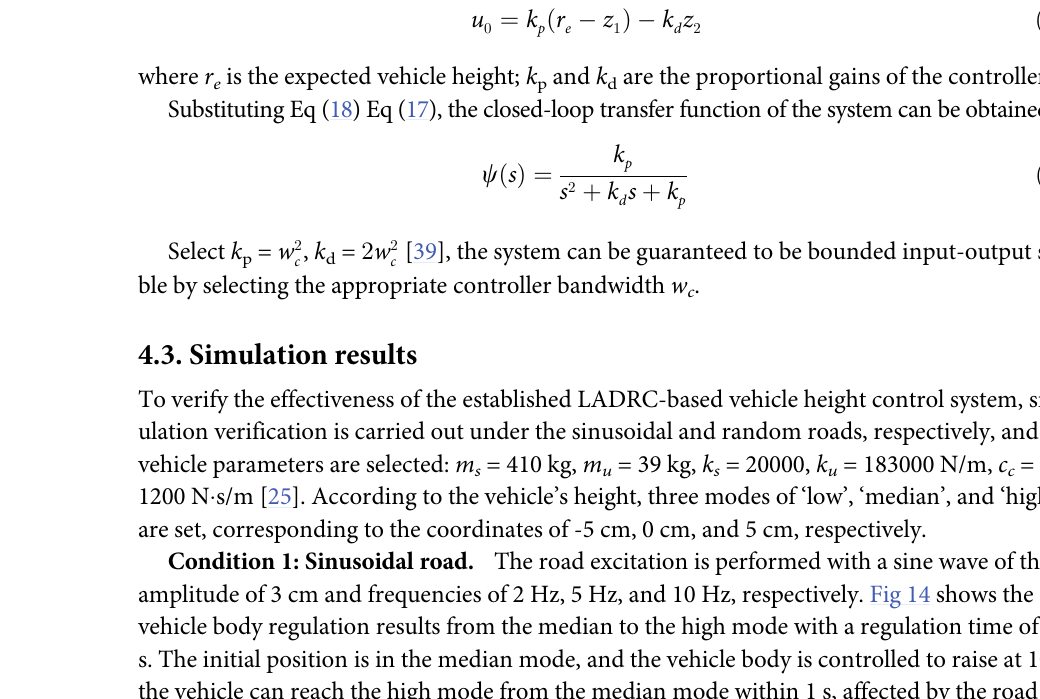
PLOS ONE | https://doi.org/10.1371/journal.pone.0274108 October 19,